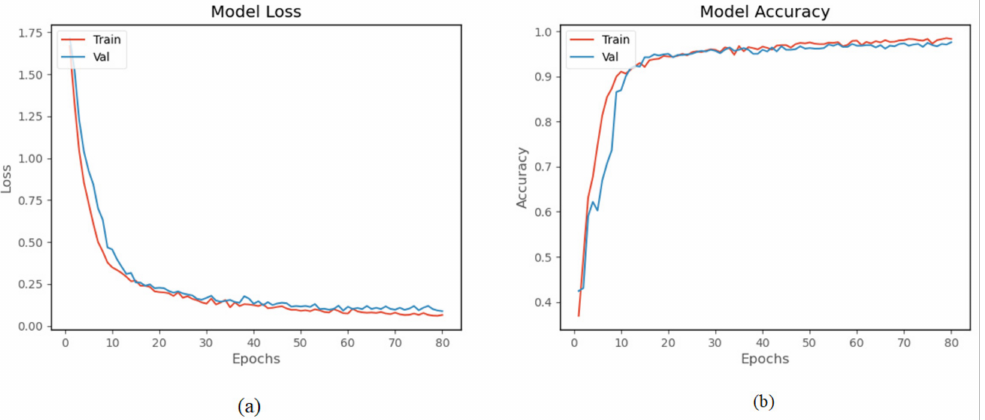
Figure 13. Experiment results on the homemade lower extremity activity dataset: ( a ) the training loss and validation loss, ( b ) the training accuracy and validation accuracy.